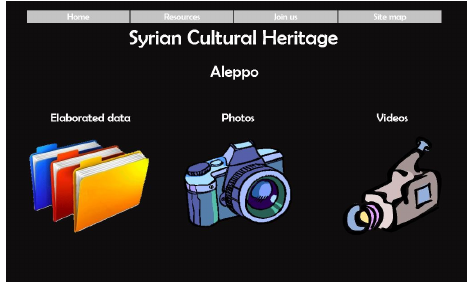
Figure 6. Selection between the CIPA data and external data